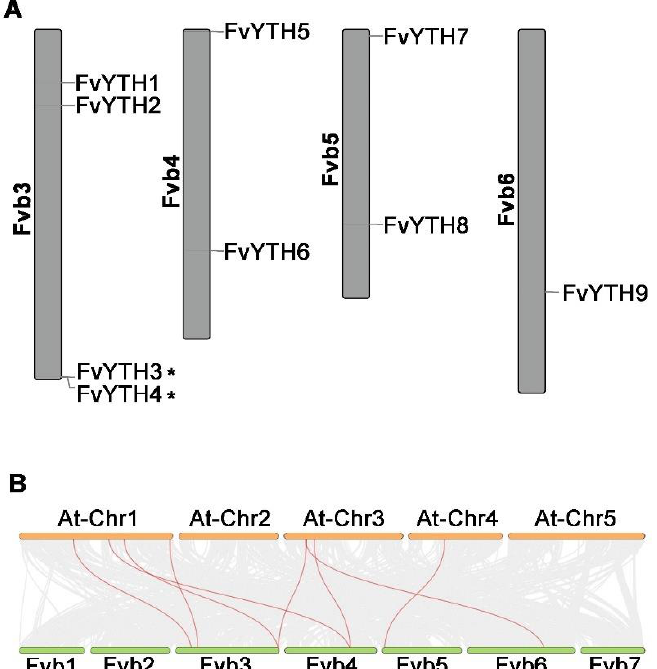
Figure 1. The locations and synteny analysis of strawberry FvYTH genes. ( A ) The locations of FvYTH genes in forest strawberry chromosomes. The chromosome number is indicated at the left of each chromosome. Gene pairs from tandem duplications are marked with *. ( B ) The synteny genes between strawberry and Arabidopsis . The red lines indicate the synteny gene pairs of YTH genes.